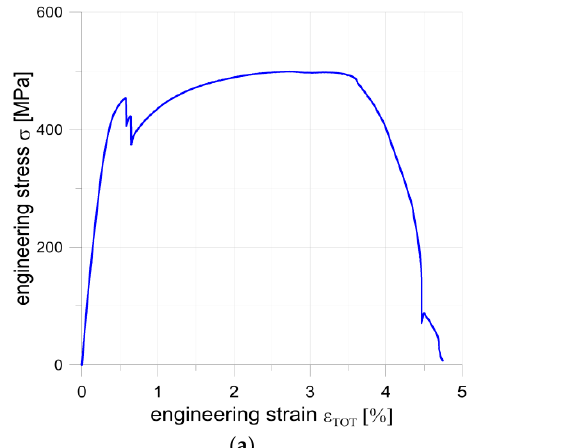
Figure 15. comparison of engineering stress–strain curve metal sample 3 and sample 5 with com- posite overlays with square holes with fillet radii R2.